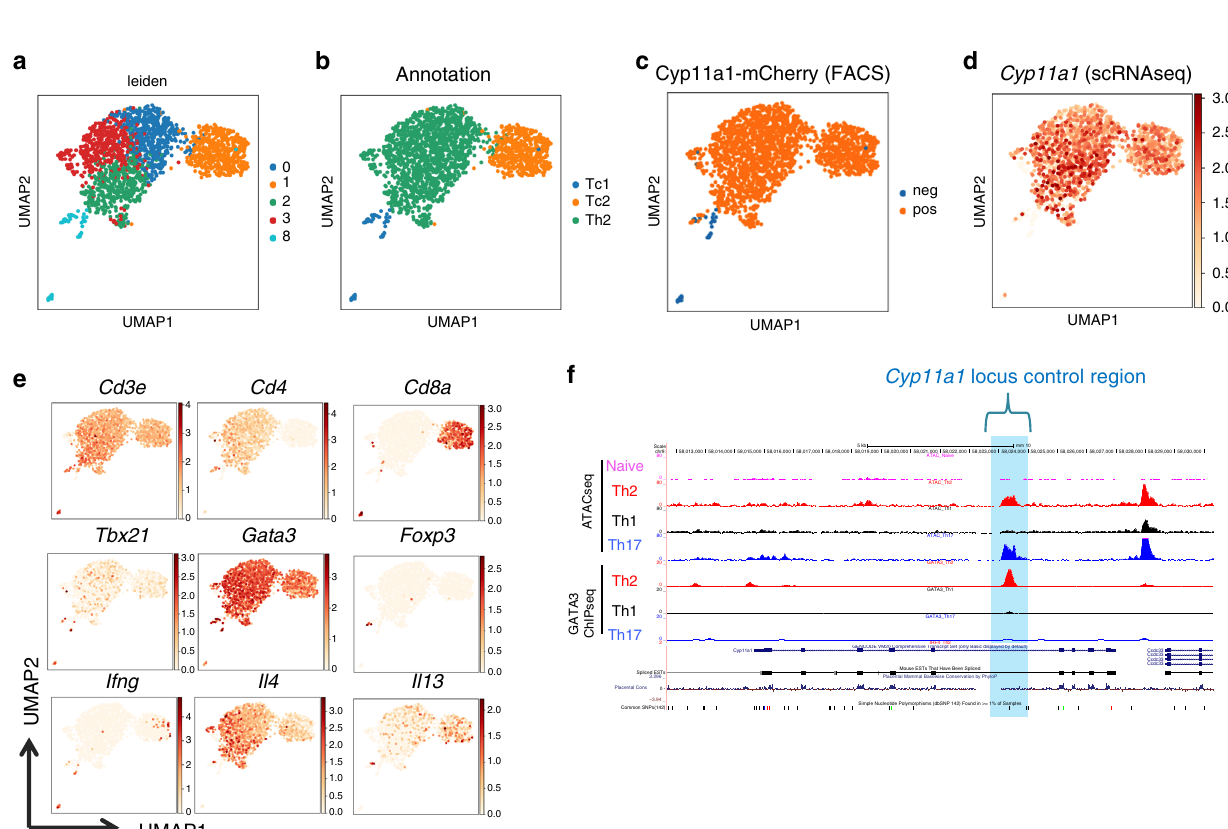
Fig. 4 Revealing gene expression identity of intratumoral Cyp11a1 + T cells by scRNAseq. a , b UMAP visualization of the tumor-in fi ltrating T cells ( a ) with annotations of the clusters ( b ). Tc1 represents type-1 CD8 + T cells, Tc2 represents type-2 CD8 + T cells, and Th2 represents type-2 CD4 + T cells. c , d mCherry protein expression accurately reports Cyp11a1 mRNA expression. Cyp11a1-mCherry protein expression according to the fl ow cytometry (FACS) data ( c ). Cyp11a1 mRNA expression in the scRNA-seq data ( d ). e Expression of cell-type-speci fi c signature genes that were used to annotate the clusters. f Determination of Cyp11a1 locus control region. Open chromatin regions were identi fi ed by ATAC-seq of T helper cells. In vitro generated Th2 and Th17 cells were used as positive control. Naïve and Th1 cells were used as negative control. Gata3 ChIP-seq data were analyzed to determine the binding site. The open chromatin region where Gata3 occupy is highlighted blue and considered as locus control T cells signi fi cantly restricted primary tumor growth rates and pregnenolone at the primary tumor site was suf fi cient to fi nal volumes (Fig. 5a). Similarly, in the experimental metastasis compensate for the Cyp11a1 de fi ciency, restoring tumor growth model, impaired lung colonization was observed in the absence to levels comparable with control mice (Fig. 5c). This suggests of T cell-expressed Cyp11a1. There was a signi fi cant reduction that the tumor restriction was a consequence of the absence of in number of metastatic foci in lungs of Cyp11a1 cKO mice pregnenolone synthesis. Similar results were obtained using the compared to the control mice (Fig. 5b). In the B16-F10 sub- EO771 breast cancer orthotopic tumor model: deletion of cutaneous melanoma model, topical application of exogenous Cyp11a1 in T cells restricted dissemination to and nodule